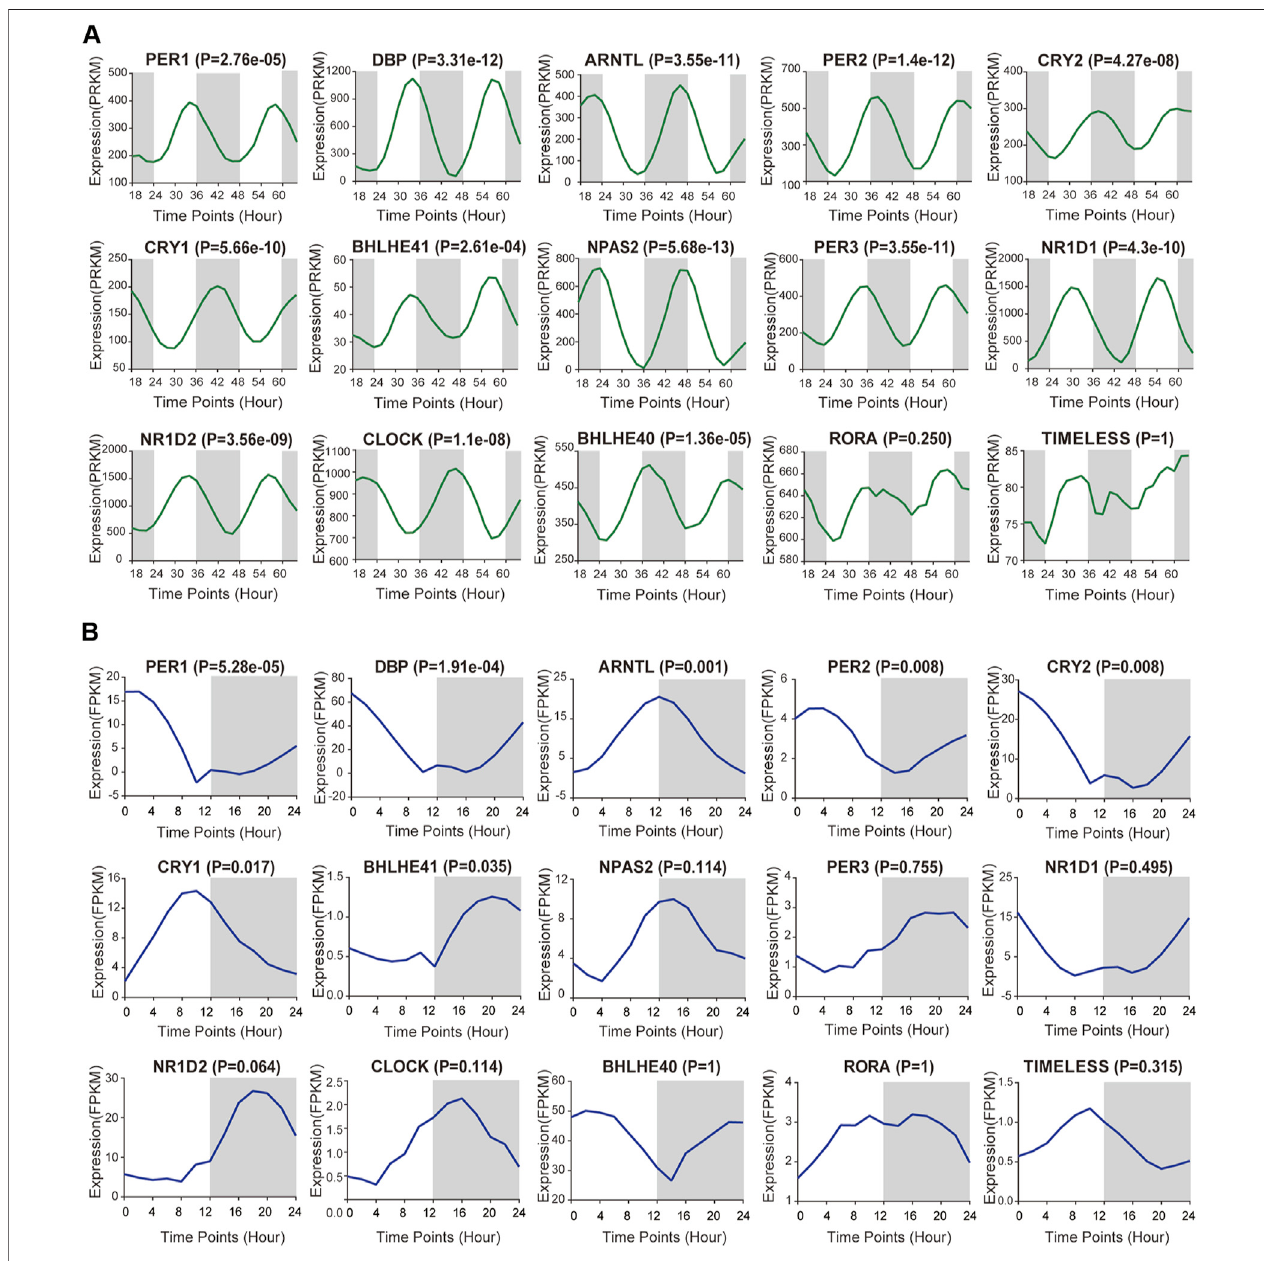
FIGURE 1 | Basic expression of core clock gene in kidney tissues. (A,B) RNA-Seq derived from two GEO databases ( Mus GSE54652, Baboon GSE98965) was used tocalculate theexpression pro fi les ofcorerhythm genesatdifferenttime intervalsintherenaltissues ofmice andbaboons,including NPAS2, PER2,DBP,ARNTL, PER3, NR1D1, CRY1, NR1D2, CLOCK, CRY2, BHLHE40, PER1, BHLHE41, RORA and